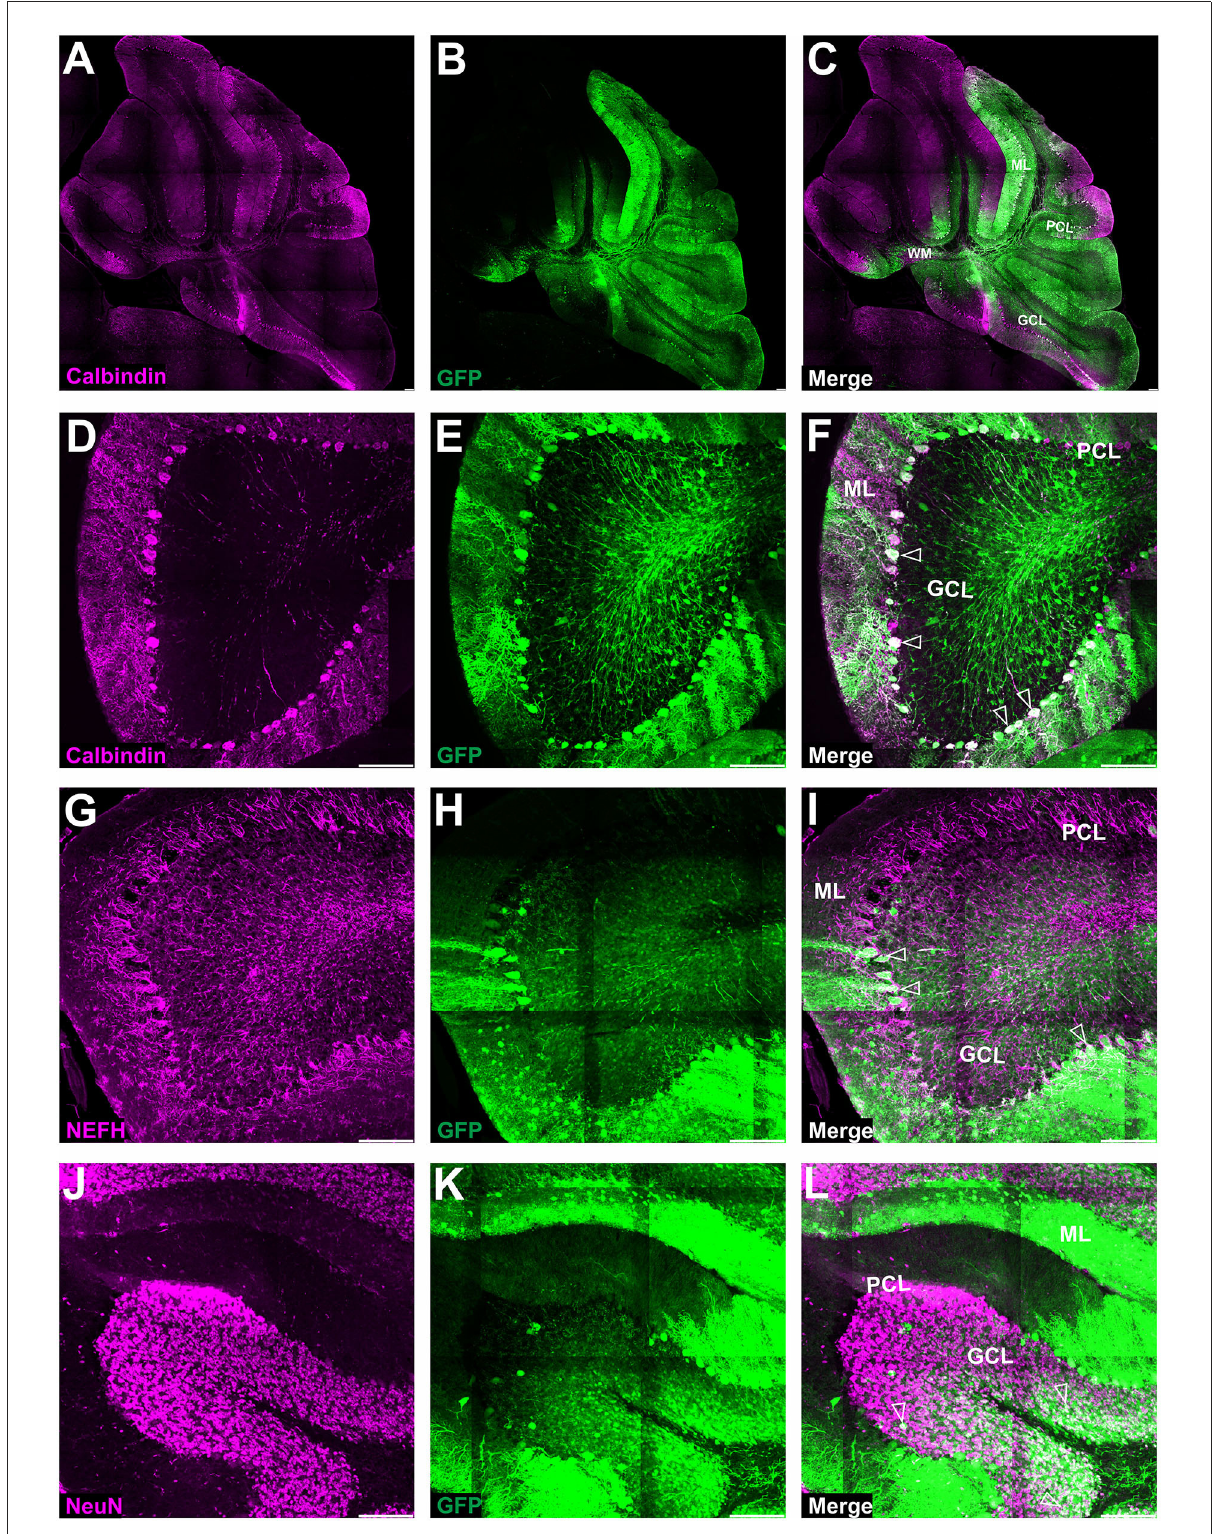
FIGURE6 Fluorescent coimmunostaining of mouse cerebellar cryosections after lobular injection of eGFP-encoding AAV-PHP.eB. Green eGFP signal (B,E,H,K) was imaged together with calbindin 1 [magenta, (C,F) ] or NEFH [magenta, (I) ], or NeuN [magenta, (L) ]. The co-localization signal (white) is present for all types of cells in the cerebellum, indicating the transduction of Purkinje cells [calbindin 1; (A,D) ], basket cells [NEFH visible